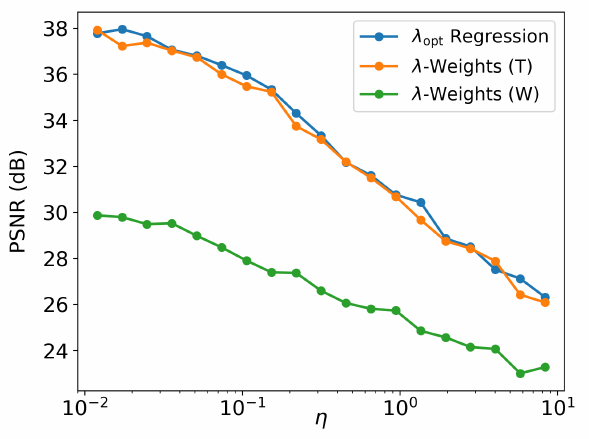
Figure 14. Mean result PSNR as a function of input noise. Table 3. Mean PSNR/SSIM values for deblurring performance, before and after E2E